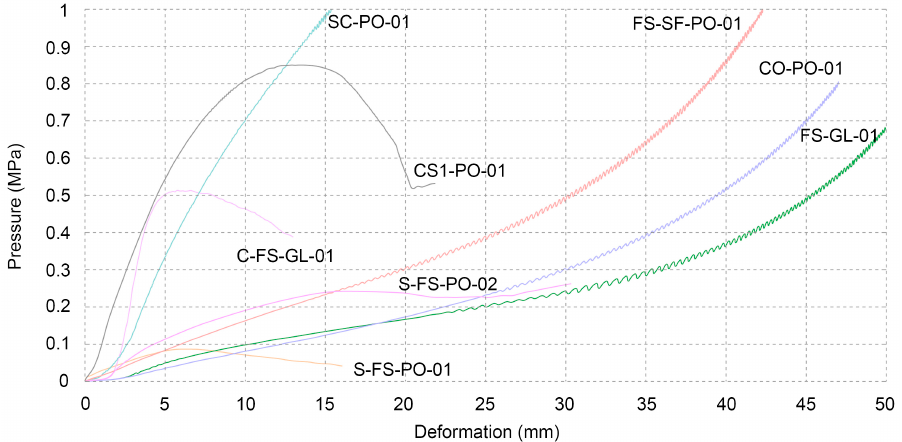
Figure 7. Compression test of various samples.